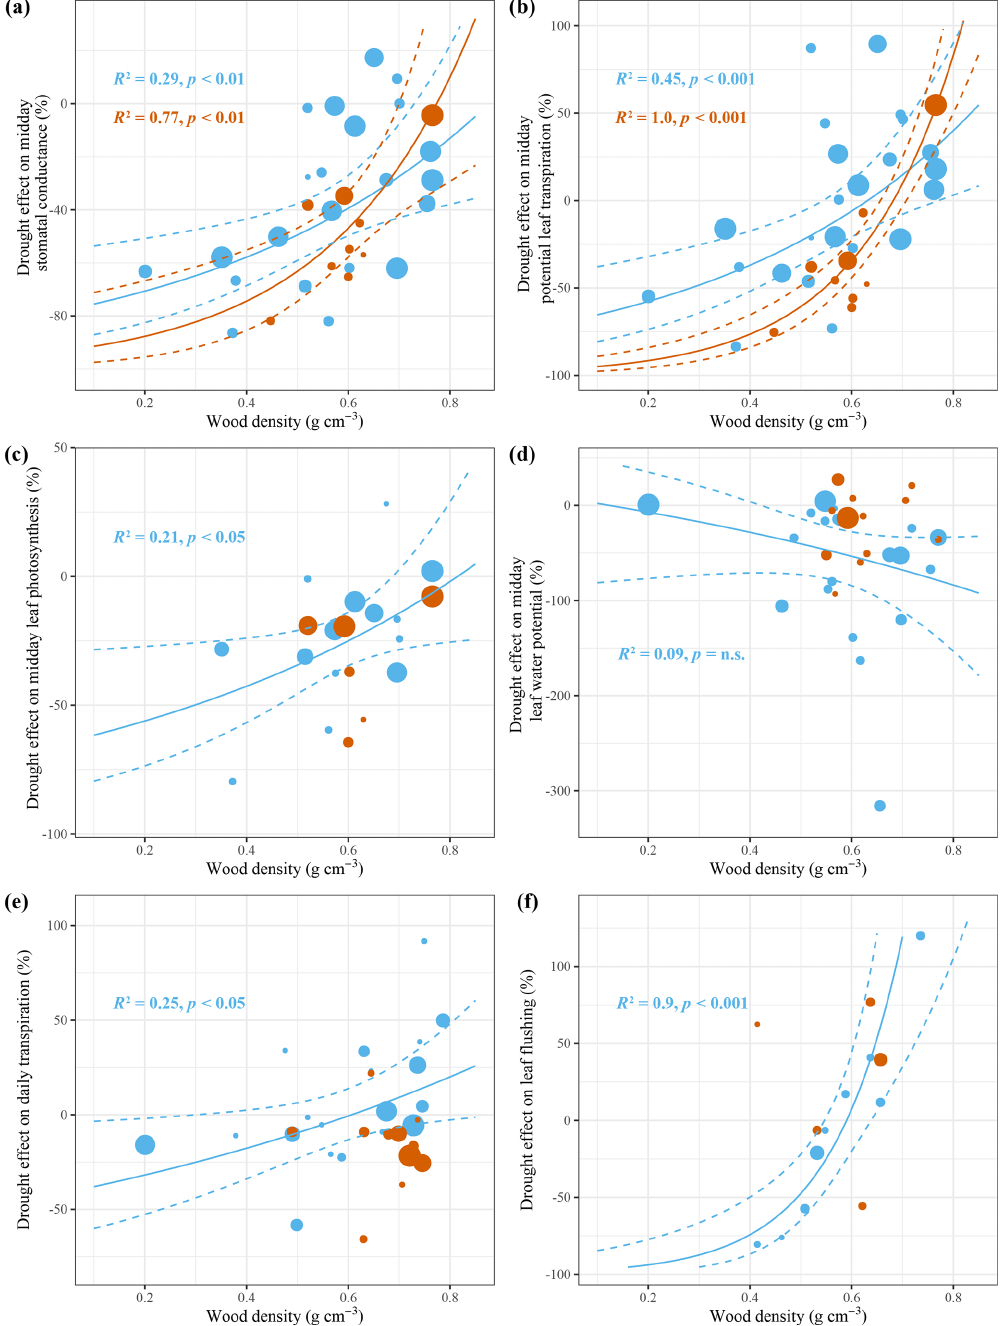
Figure 4. Effect size of leaf- and tree-scale responses to seasonal (blue) and episodic (red) drought for different studies against the study- averaged wood density. The R 2 values indicate the amount of heterogeneity accounted for in each mixed-effect model with wood density as a moderator. On the leaf-scale, studies with a low average wood density show a decline in stomatal conductance (a) , potential leaf transpiration (b) and photosynthesis (c) in response to seasonal and episodic drought, while midday leaf water potential is not changed. On the tree scale, studies with a low average wood density show a decline in daily tree transpiration (e) and leaf flushing (f) in response to seasonal drought but not episodic drought. The size of the points is determined based on the inverse of the sampling variance of the particular study (i.e. precision), showing larger points for more precise studies. The sampling variances are used to provide weights for the different studies in the mixed-effect model. The test statistics are retrieved from a mixed-effect model testing the significance of wood density as a moderator variable in the drought response. The solid line is the model prediction, and the dashed lines are the 95% confidence intervals. Regression lines are only drawn if the relationship is significant ( p< 0 .